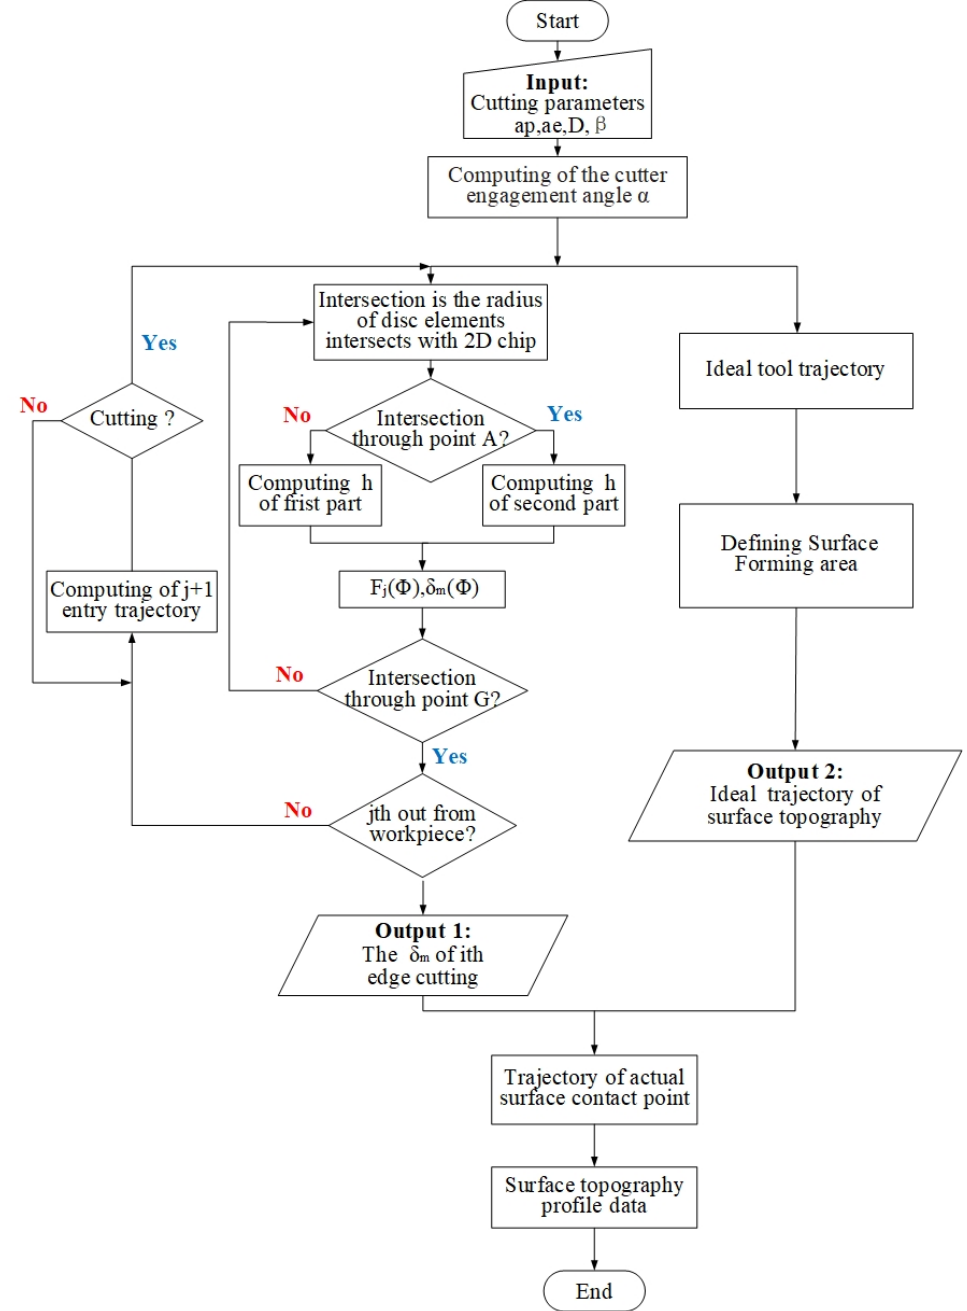
Figure 9. The flowchart of milling surface topography simulation of thin-walled parts.